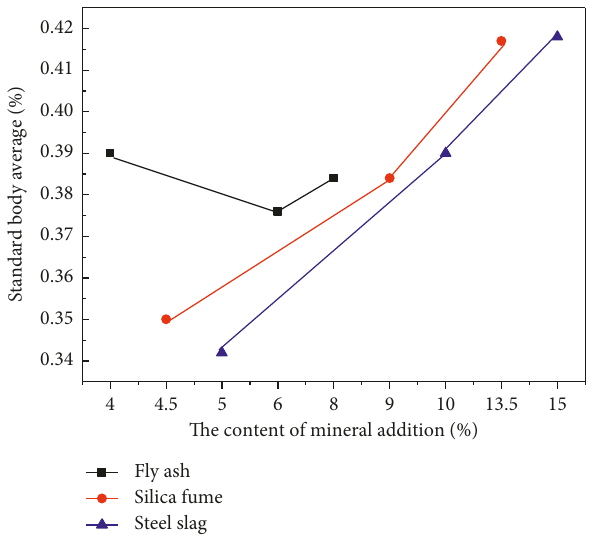
Figure 11: The relationship between the standard consistency average and the added mineral content.